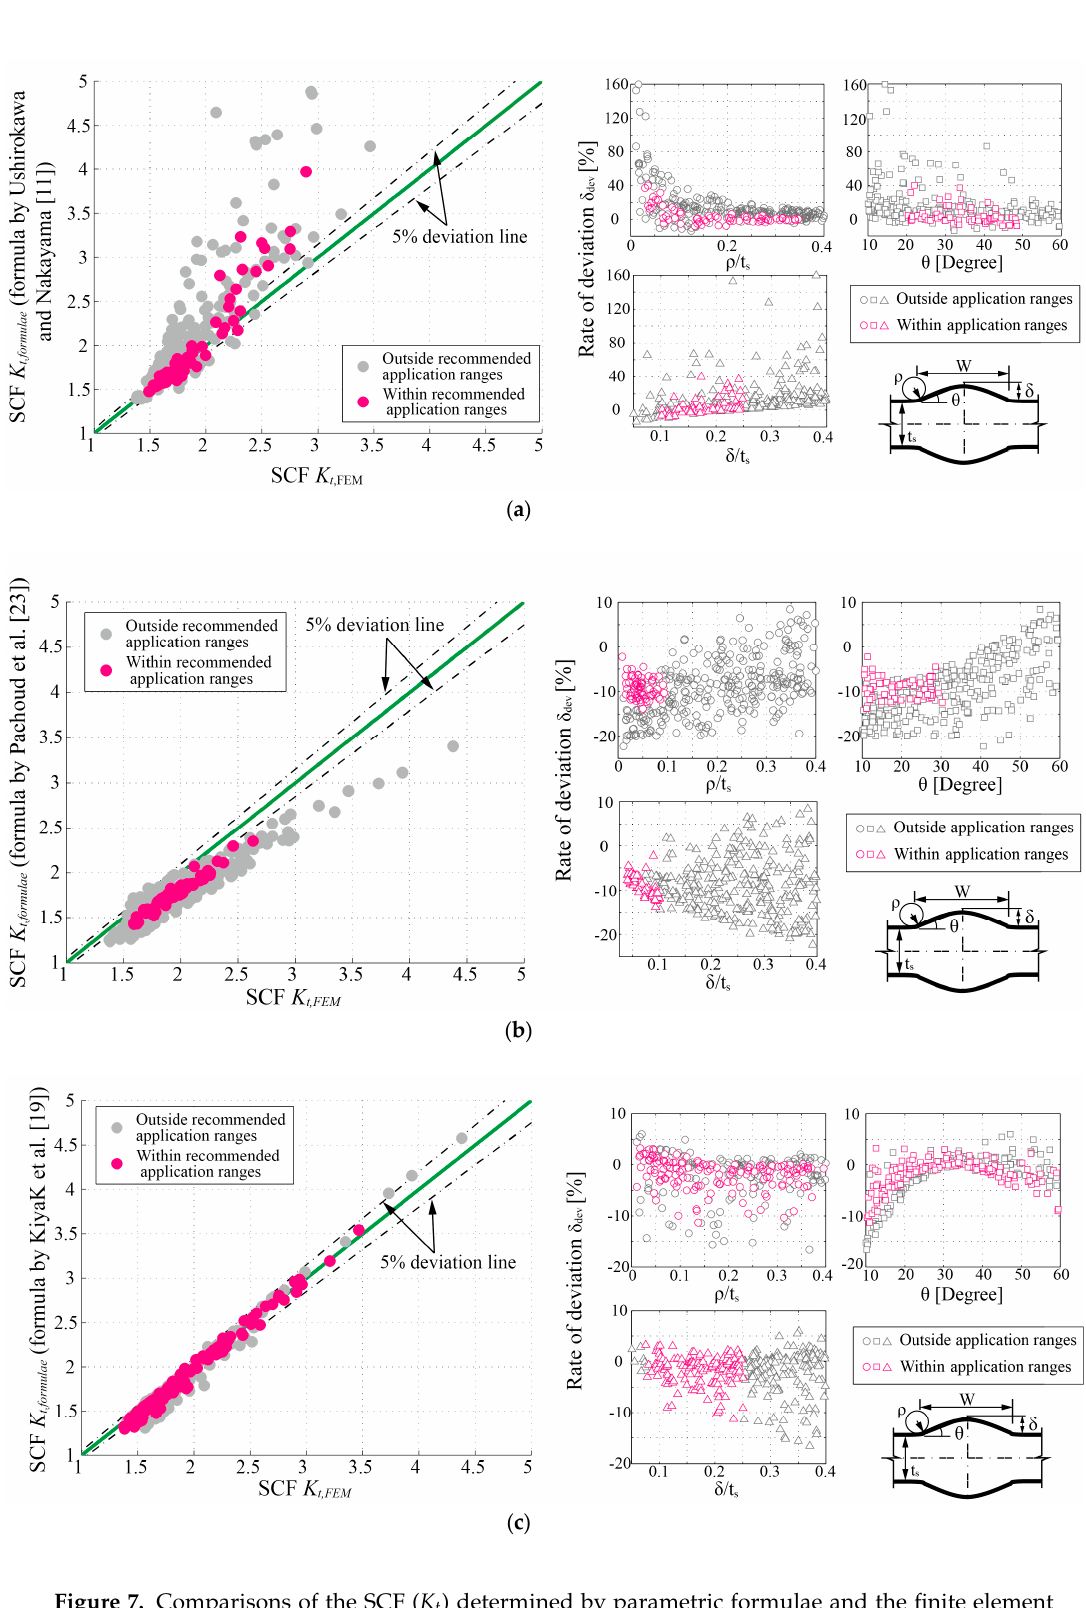
Figure 7. Comparisons of the SCF ( K t ) determined by parametric formulae and the finite element method (FEM): ( a ) Ushirokawa and Nakayama [11]; ( b ) Pachoud et al. [23]; ( c ) Kiyak et al.